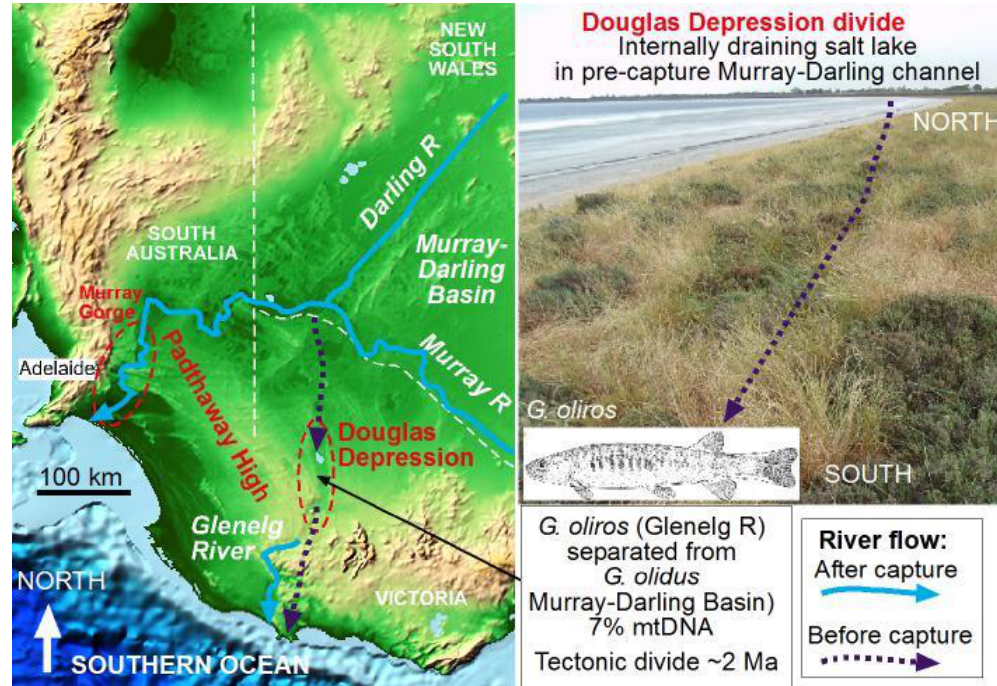
Figure 5. Slow tectonic processes, and therefore slow erosion, in southern Australia have permitted preservation of evidence of drainage reorientation in the lower reaches of the Murray–Darling River system. The river formerly discharged along a subtle tectonic feature, the Douglas Depression [38]. Uplift of a broad gentle warp, the Padthaway High, in the early Pleistocene halted this discharge channel, initially forming an inland lake until a new discharge channel formed at Murray Gorge. This drainage re-orientation is proposed to have isolated several freshwater lineage pairs, likely including the predominantly southwest Victorian Galaxias oliros which is sister to the remainder of the G. olidus complex [22], discussed in [20].